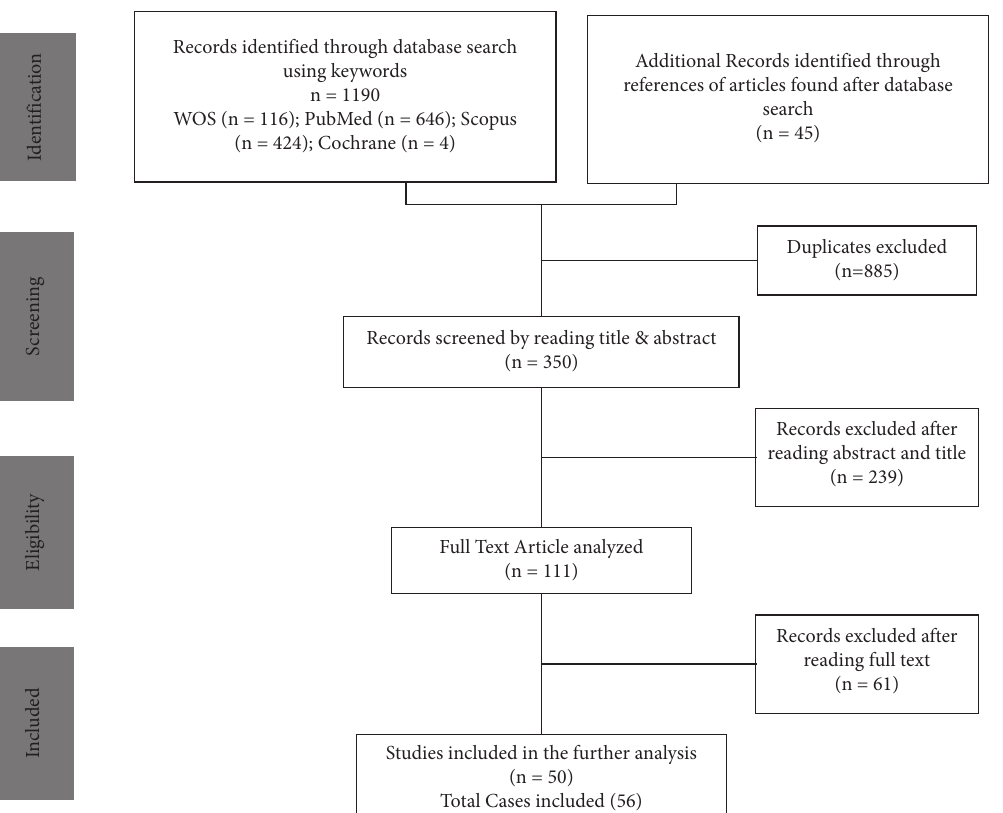
Figure 1: Flow diagram used for data